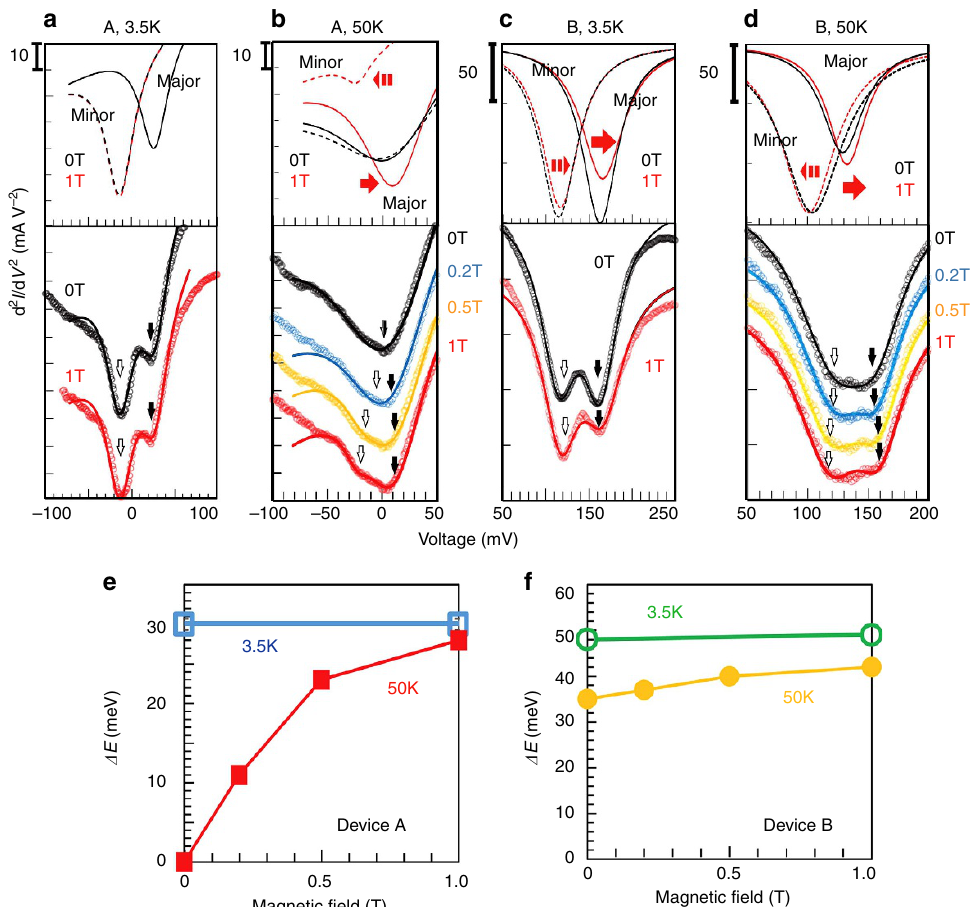
Figure 3 | Magnetic field dependence of the spin-splitting energy of (In,Fe)As. ( a – d ) Evolution of the d 2 I /d V 2 – V curves with external magnetic field strength. Experimental data (open circles) and their fitting curves (solid curves) are shown in the bottom panels, where white and black arrows indicate the minority and majority spin valley centres, respectively (The vertical axes are shifted for clear vision). The fitting curves are the sum of two Lorentzian curves, fitted for each valley. The fitting Lorentzian curves for the data at 0T (black) and 1T (red) are shown in the top panels. a and b are the results of device A at 3.5 and 50K, c and d are the results of device B at 3.5 and 50K, respectively. ( e and f ) Zeeman splitting energies D E at 3.5 and 50K of devices A ( e ) and B ( f ). The external magnetic field was applied along the [100] axis in the film